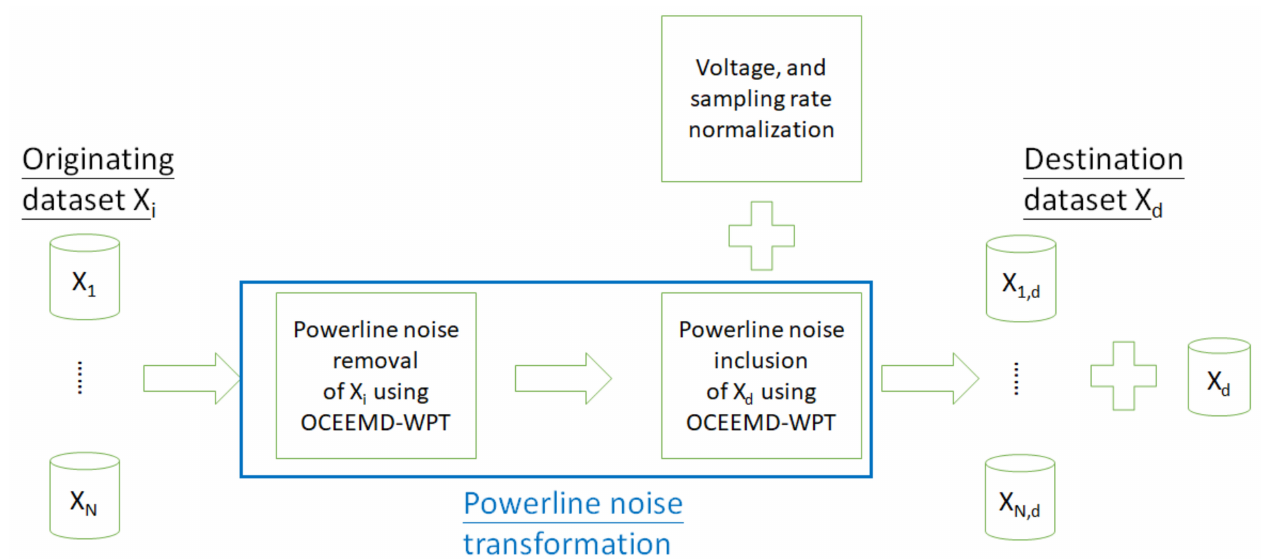
Figure 1. Conceptual flow of the powerline noise transformation approach via optimized complete ensemble empirical model decomposition and wavelet packet transform